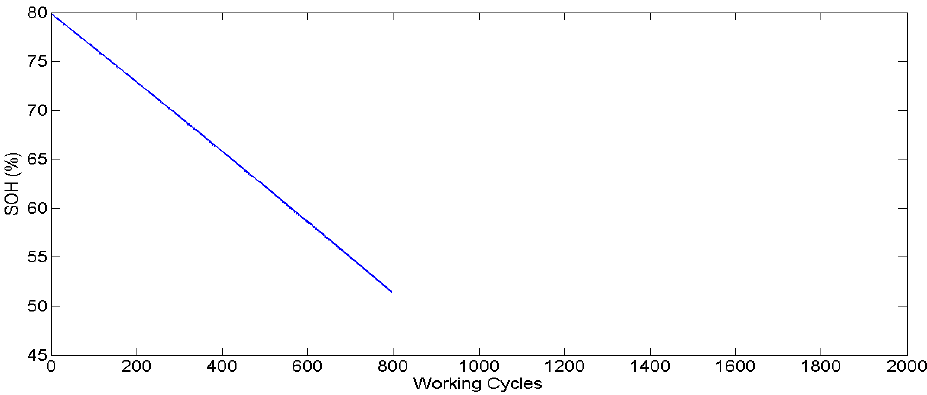
Figure 5. Aging evolution of second ‐ life EV batteries following the second scenario load.